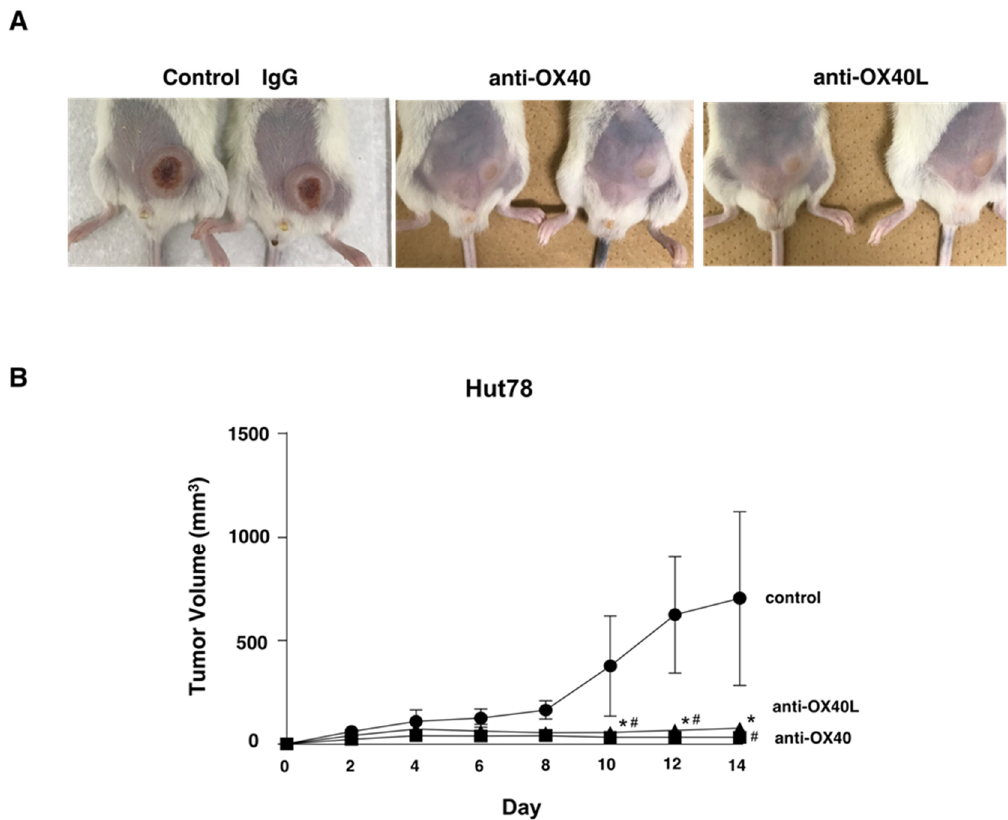
Figure 6. Anti-OX40 and anti-OX40L antibodies suppressed tumor growth. Hut78 cells (5.0 × 10 6 cells) in 100 µ L of PBS were injected subcutaneously into the shaved left abdomen of NSG mice. Anti-OX40 or anti-OX40L neutralizing antibodies were injected on days 0, 4, 7, and 11 intraperitoneally. ( A ) Representative images are shown. ( B ) The tumor volume was calculated using the equation: V = π (L1 × L2 2 )/6, where V = volume (mm 3 ), L1 = longest diameter (mm), and L2 = shortest diameter (mm). Values are means ± SEM. *,# p < 0.05 by Mann–Whitney U test compared with control group.